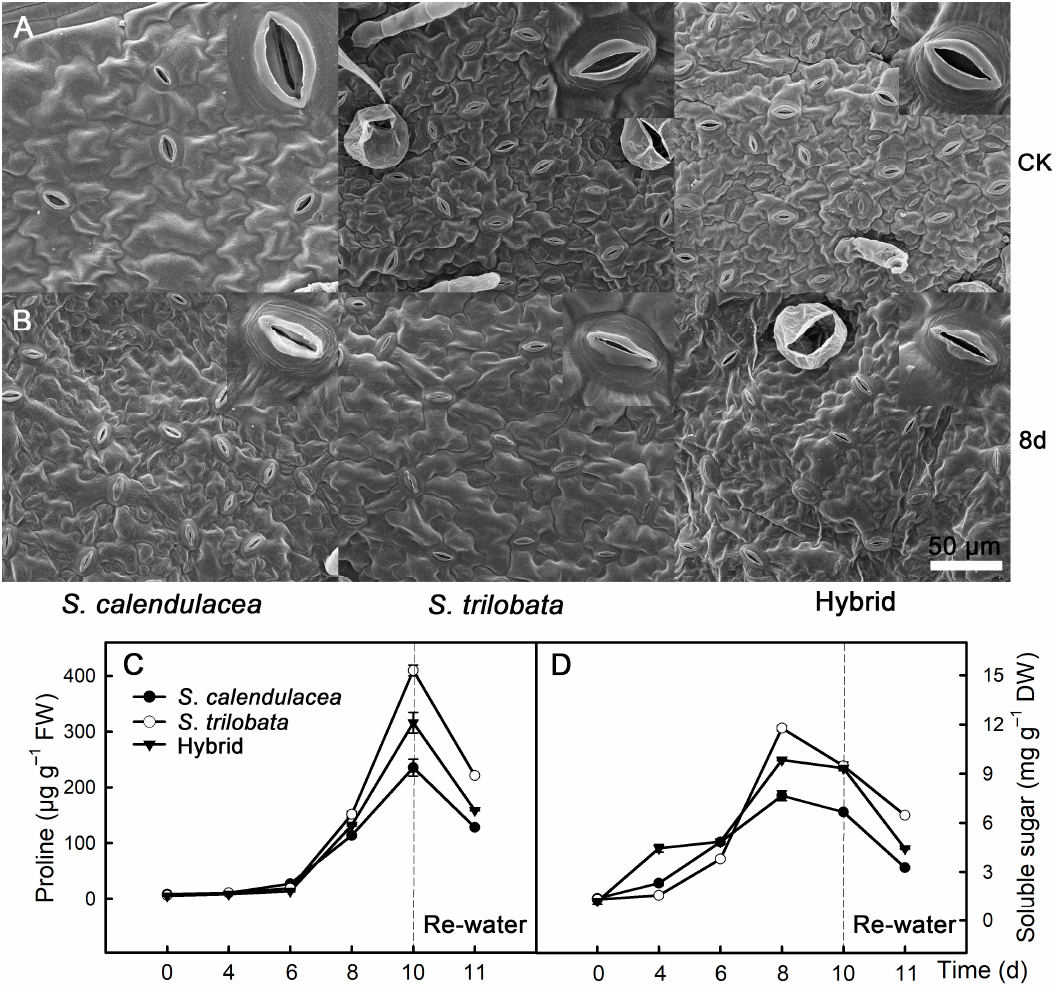
Figure 2. Pore size and osmoregulation substance content after eight days of normal irrigation (CK) and drought stress treatment (8 d), leaf stomatal size ( A , B ), and changes of proline ( C ) and soluble sugar ( D ) contents in leaves of S . calendulacea , S . trilobata and their hybrid under drought stress and re-watered.